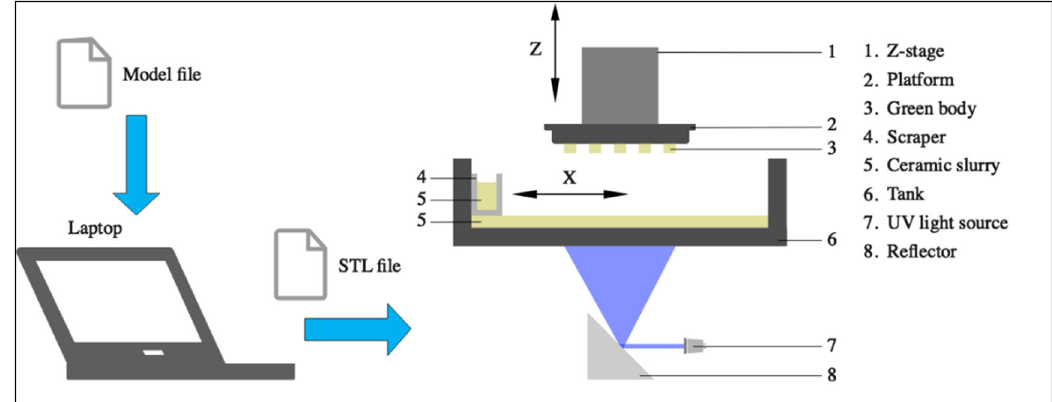
Figure 2. The schematic diagrams of DLP 3D printing procedures.